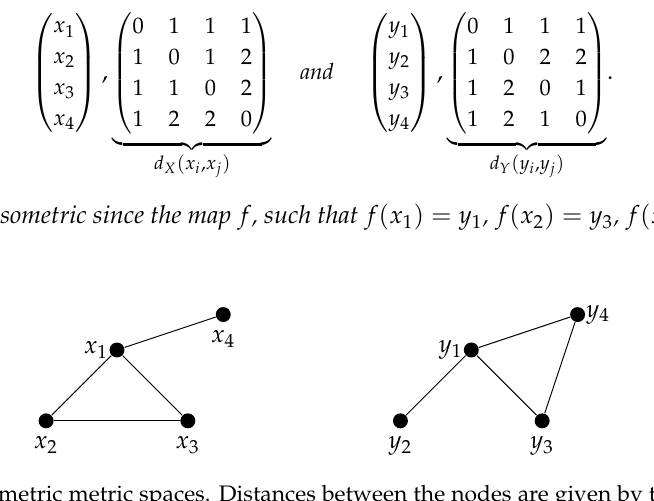
Figure 2. Two isometric metric spaces. Distances between the nodes are given by the shortest path, and the weight of each edge is equal to 1.